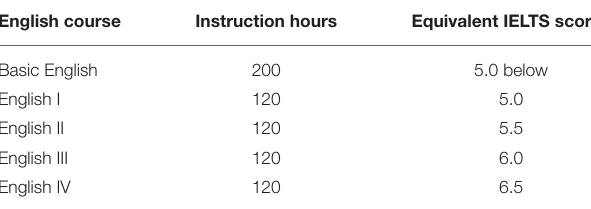
TABLE 1 | English program structure and IELTS band.